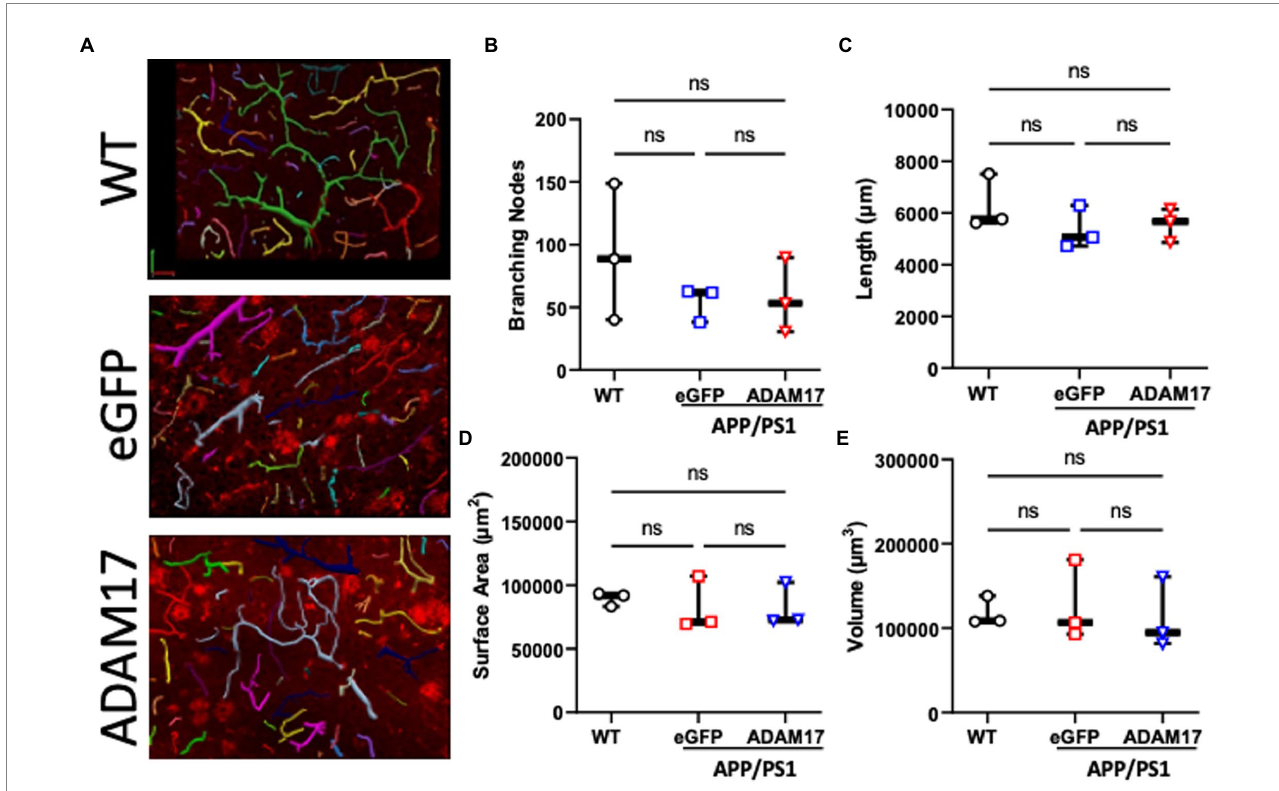
FIGURE 7 ADAM17 re-expression had no effect on the vascularization of the cerebral cortex in APP/PS1 mice. (A) Representative 3-dimensional reconstructions of the cerebral small vessel networks in WT, eGFP, and ADAM17 treated APP/PS1 mice. (B–E) No differences in the number of branching nodes, total vessel length, vessel surface area, or vessel volume was found between the three groups. Images were taken at 20X magnification, 0.5 μ m slices in the z-plane. n =3 fields of view per mouse, 3 mice per group. * p < 0.05. Kruskal-Wallis test was